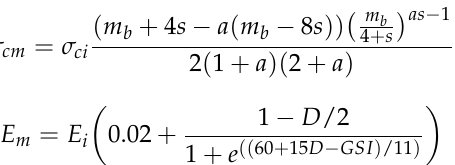
Figure 7. ( a ) UCS model. ( b ) Stress-strain curve of the coal mass sample under an ideal rigid loading condition.